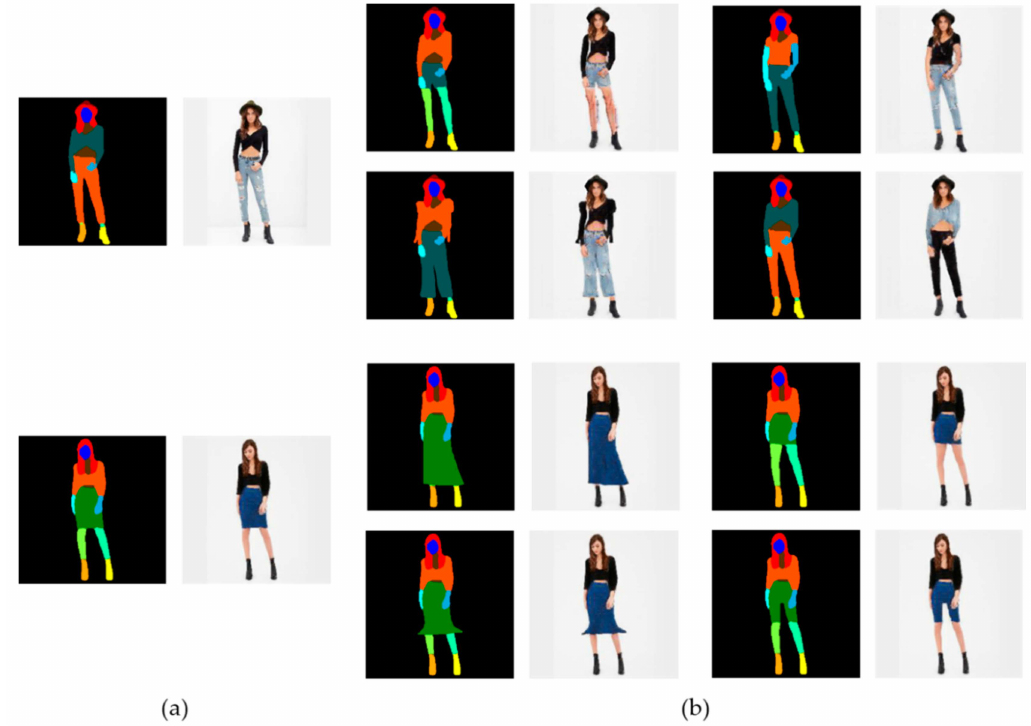
Figure 11. Segmentation images and corresponding generated images. ( a ) Original segmentation and style images. ( b ) Manipulated segmentation images and synthesized results based on